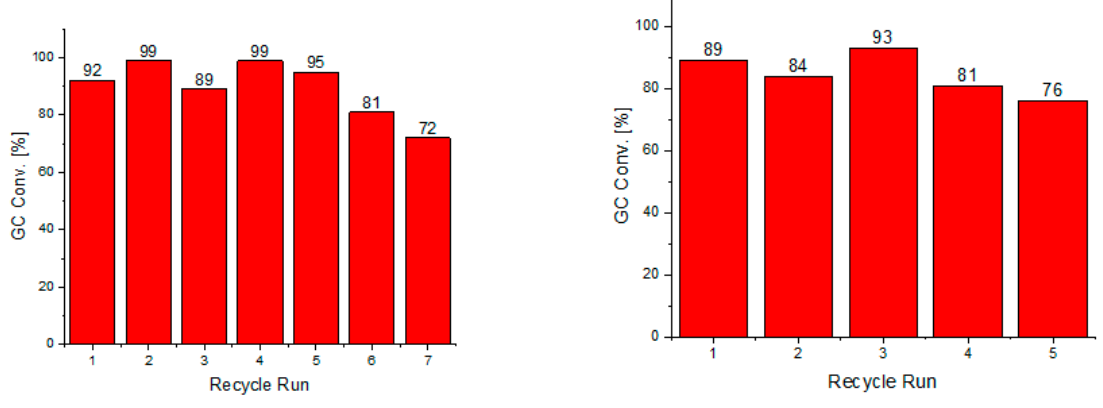
Figure 11. Recycling of C2; ( left ) 1 mol% of Pd, ( right ) 0.5 mol% of Pd.